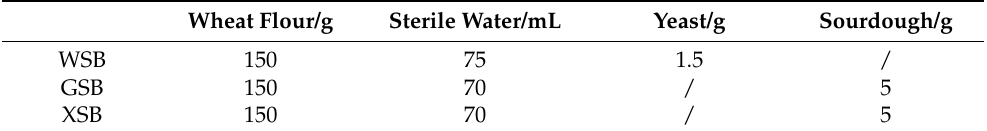
Table 1. Recipe for fermented